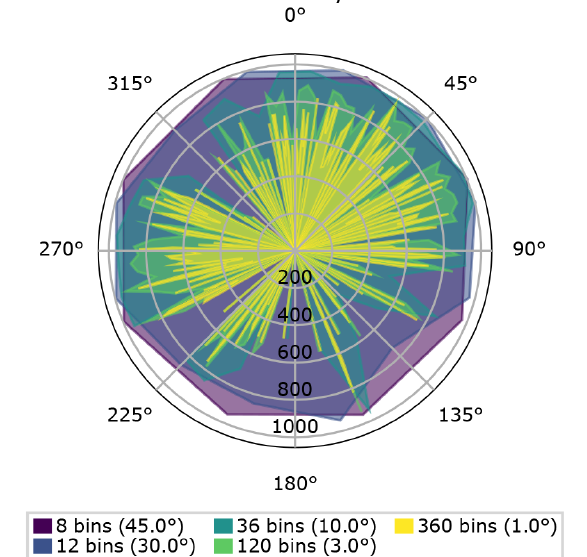
Figure A1. Number of stations for each bin for different bin sizes. Distribution is rather homogeneous for 30 and 45 ◦ bins. With smaller bin sizes bias increases, which downweights back-azimuths with low event coverage.